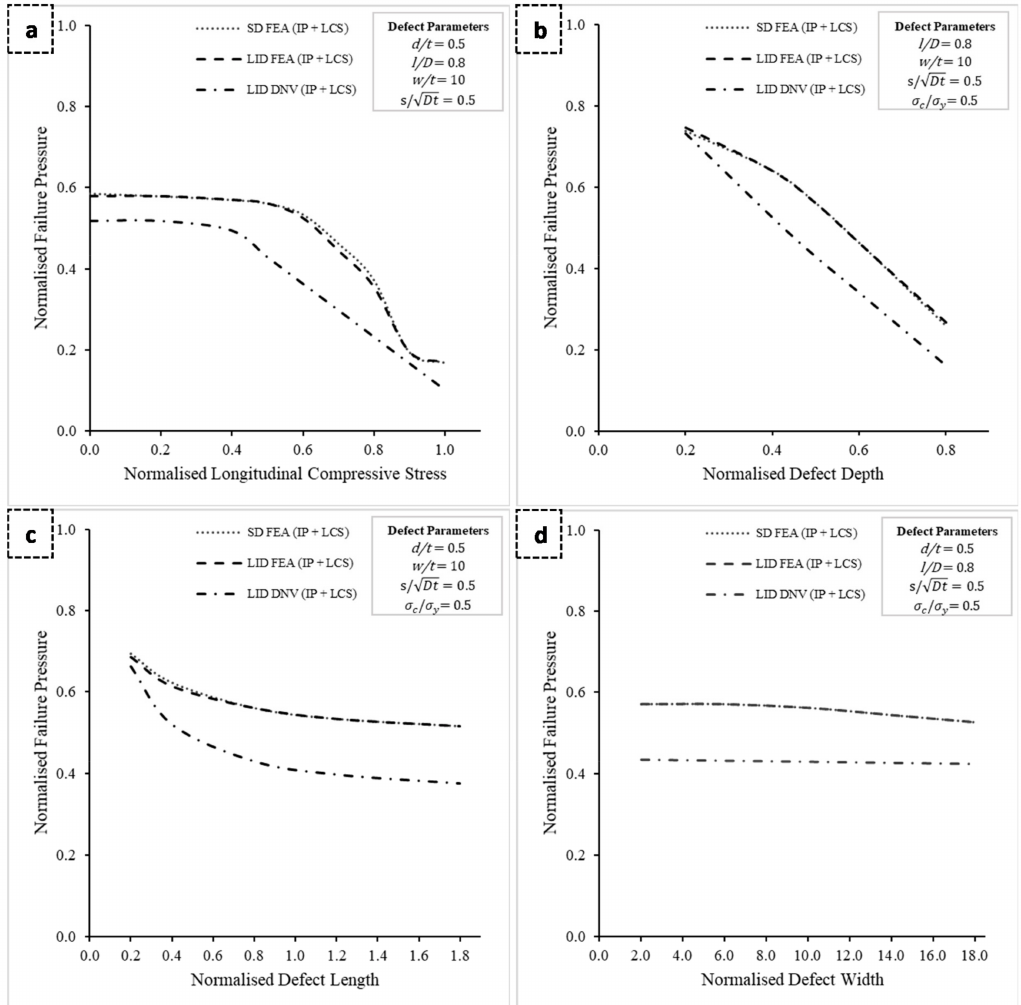
Figure 7. FEA and DNV predictions of normalised failure pressure predictions versus normalised corrosion defect parameters and load applied: ( a ) normalised failure pressure versus normalised longitudinal compressive stress, ( b ) normalised failure pressure versus normalised defect depth, ( c ) normalised failure pressure versus normalised defect length, ( d ) normalised failure pressure versus normalised defect